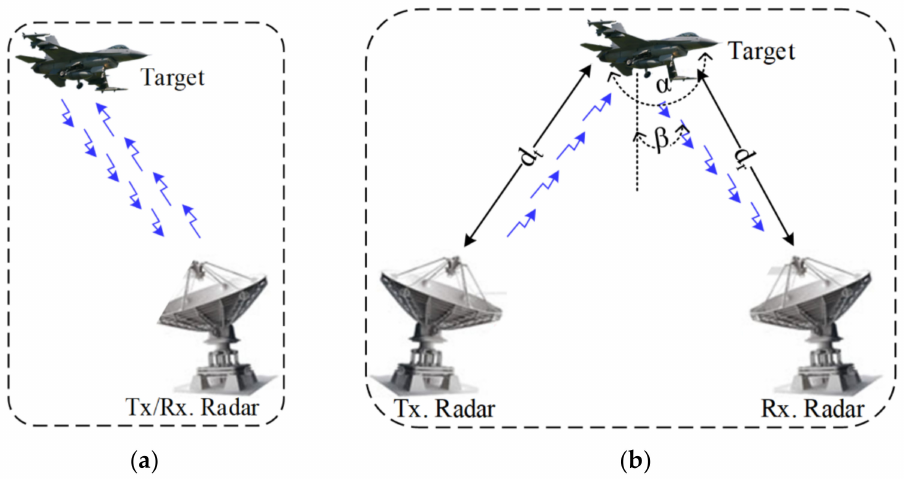
Figure 1. Illustration of ( a ) a monotonic, and ( b ) bistatic mode of operation.